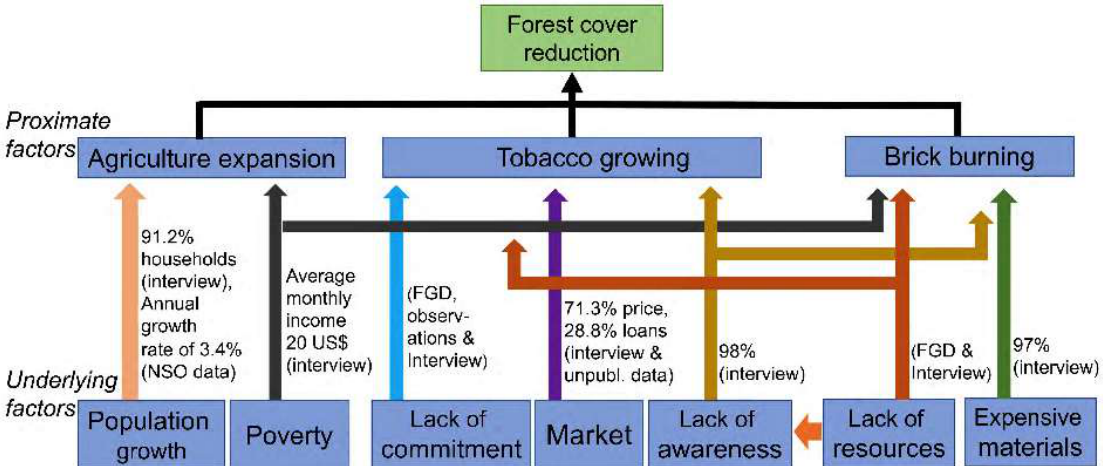
Figure 12. Summary of the interaction between underlying and proximate factors of deforestation in Mwazisi.